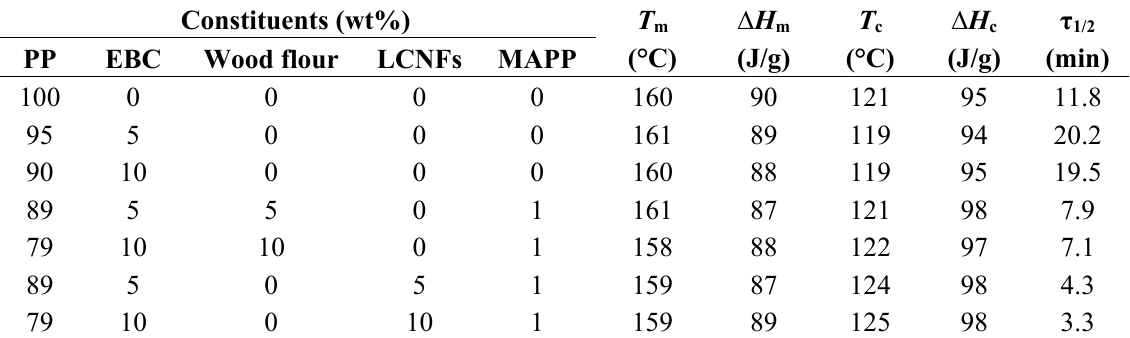
Table 1. Melting temperatures ( T m ), heats of fusion (∆ H m ), crystallization temperatures ( T c ), crystallization enthalpies (∆ H c ), and isothermal crystallization half-times at 135 °C (τ 1/2 ) of PP, the PP/EBC blends, and the fabricated